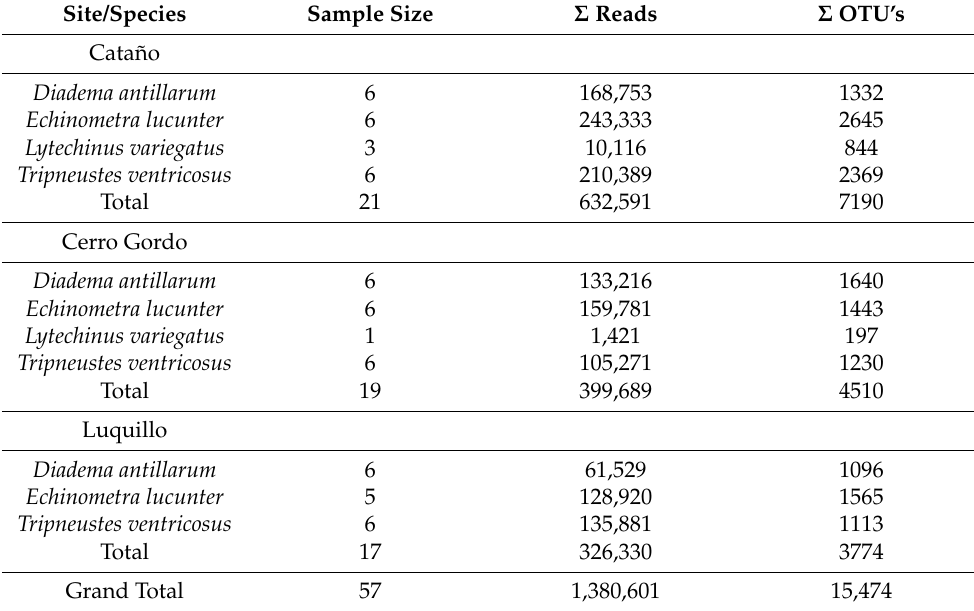
Table 1. Sample collection per animal species, with numbers of reads and OTUs by sites. Three samples were removed due to the low number of reads.